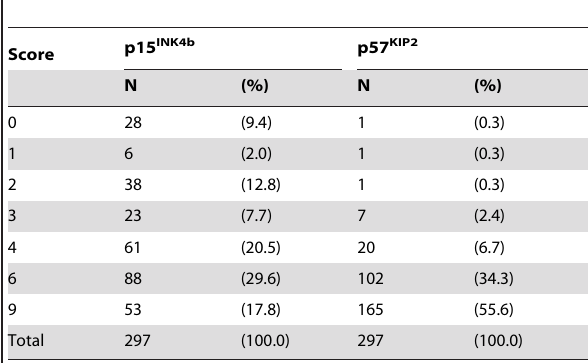
Table 1. Immunostaining results for p15 INK4b and p57 KIP2